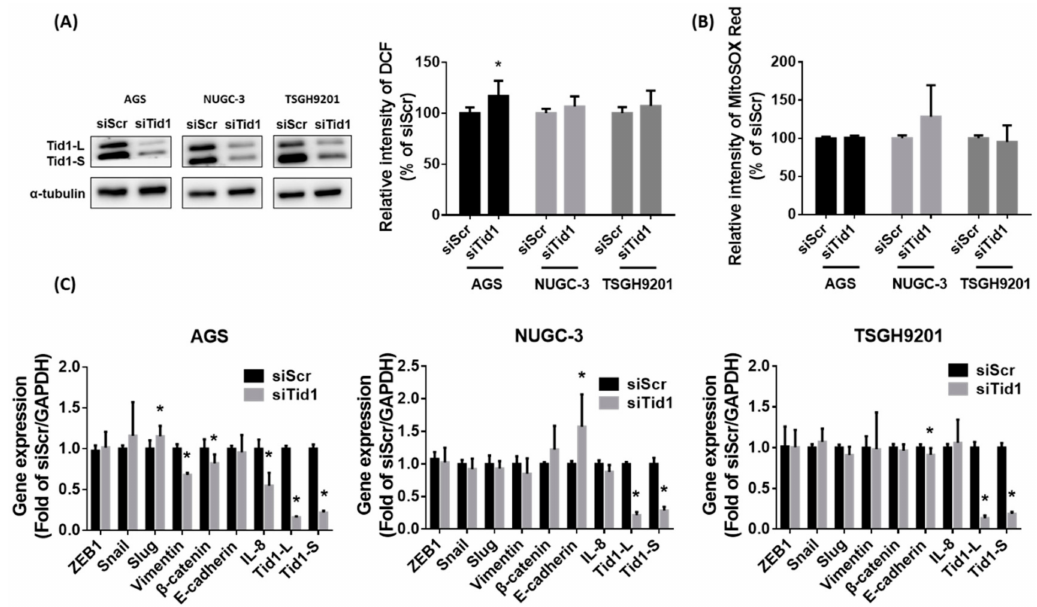
Figure 6. E ff ect of Tid1 knockdown on cellular, mitochondrial reactive oxygen species (ROS) and the gene expressions of epithelial mesenchymal transition (EMT) and interleukin 8 (IL-8) of gastric cancer cells. ( A , B ) The e ff ect of Tid1 knockdown on cellular ( A ) and mitochondrial ( B ) ROS was evaluated by flow cytometry with dichlorodihydro-fluorescein diacetate (DCFH-dA) and MitoSOX Red staining, respectively. ( C ) The e ff ect of Tid1 knockdown on EMT / IL-8 gene expression was evaluated by RT-real-time PCR. The e ffi ciency of Tid1 knockdown was confirmed by Western blot ( A , B ) or RT-realtime PCR ( C ). Data are shown as the mean ± SD of at least three independent experiments. *, p < 0.05, compared with the siRNA for scramble (siScr) control